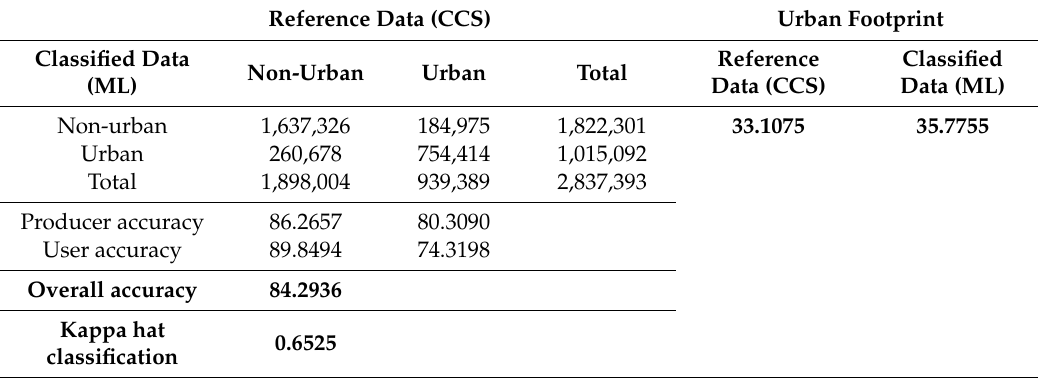
Figure 11. ( a ) Supervised classification (using ML classifier) run over the same stack of interferometric coherence images used for the Venice area, but in a different target area, which includes the province of Padova. ( b ) Accuracy assessments using CCS as a reference map. Table 7. Error matrix related to ML classification performed on the target area of Padova (Figure 11).